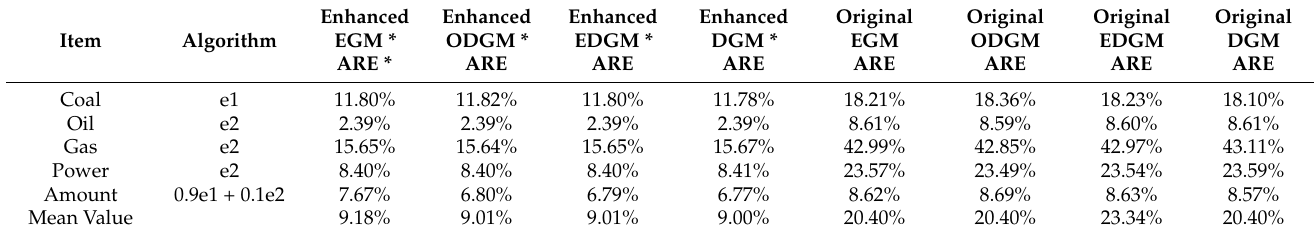
Table 4. Mean value of absolute relative error report about energy consumption data for enhanced algorithms during